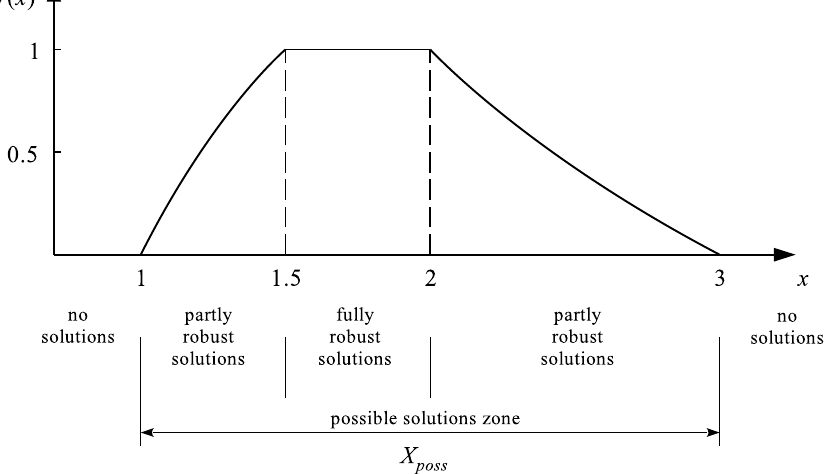
Figure 7. Distribution of the robustness degree r ( x ) of control x as illustration explaining Lodwick’s interval equation